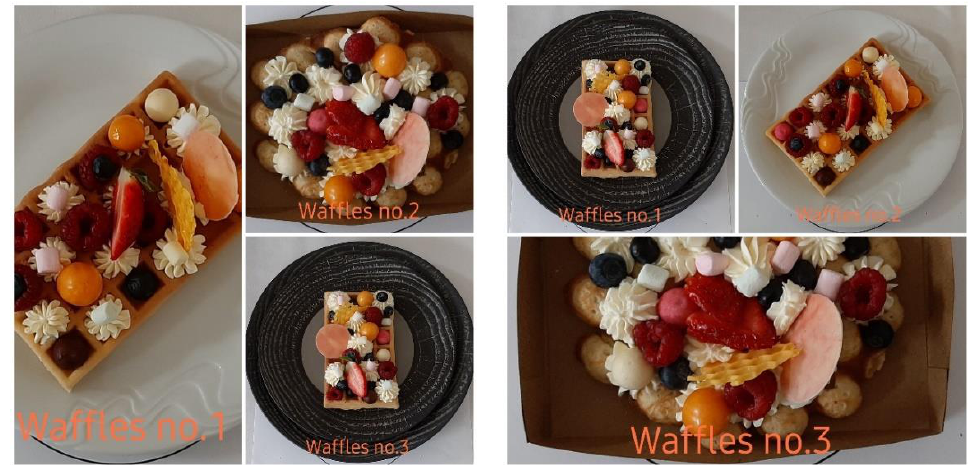
Figure 1. Testing variants of individual visual designs.